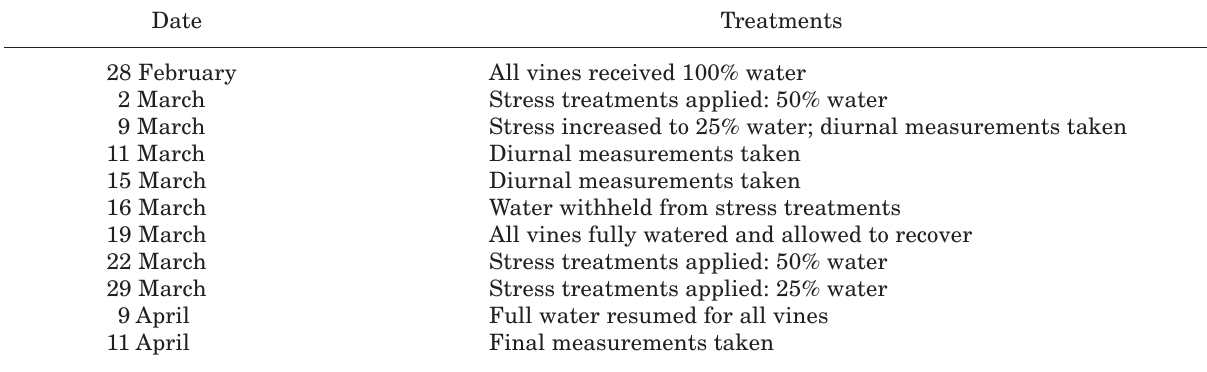
Table 2. Watering schedule for potted Zinfandel grapevines in Year 2,